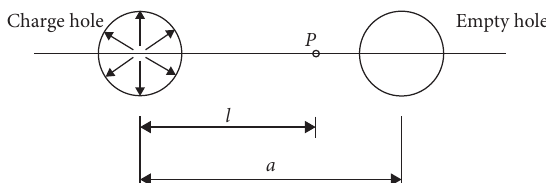
Figure 2: Layout of the empty hole in empty-hole directional blasting.